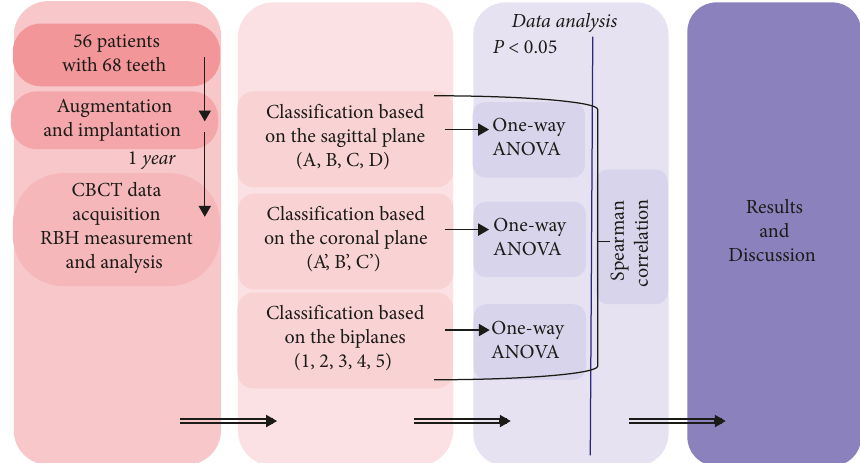
Figure 2: Flow chart of this study.